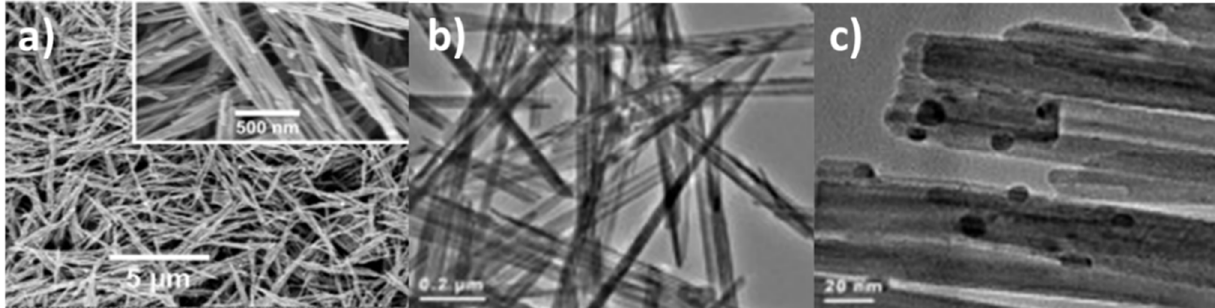
Figure 9. FESEM micrograph of [Ag]-OMS-2 catalyst ( a ), TEM and HR-TEM images showing the morphology of short nanofibers ( b ) and low magnification image showing the morphology of short nanofibers with Ag nanoparticles ( c ). Images have been extracted from [164].